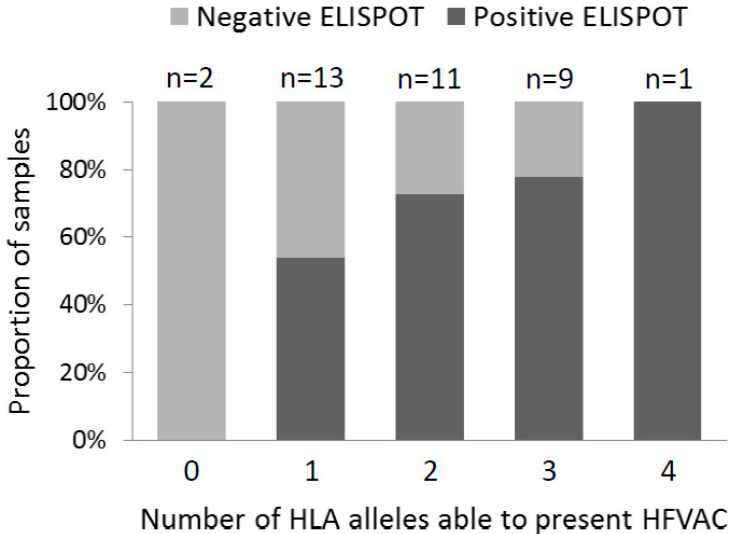
Figure 1. ELISPOT reactivity to HFVAC peptides according to the number of HLA-A and -B alleles fitting with their presentation.